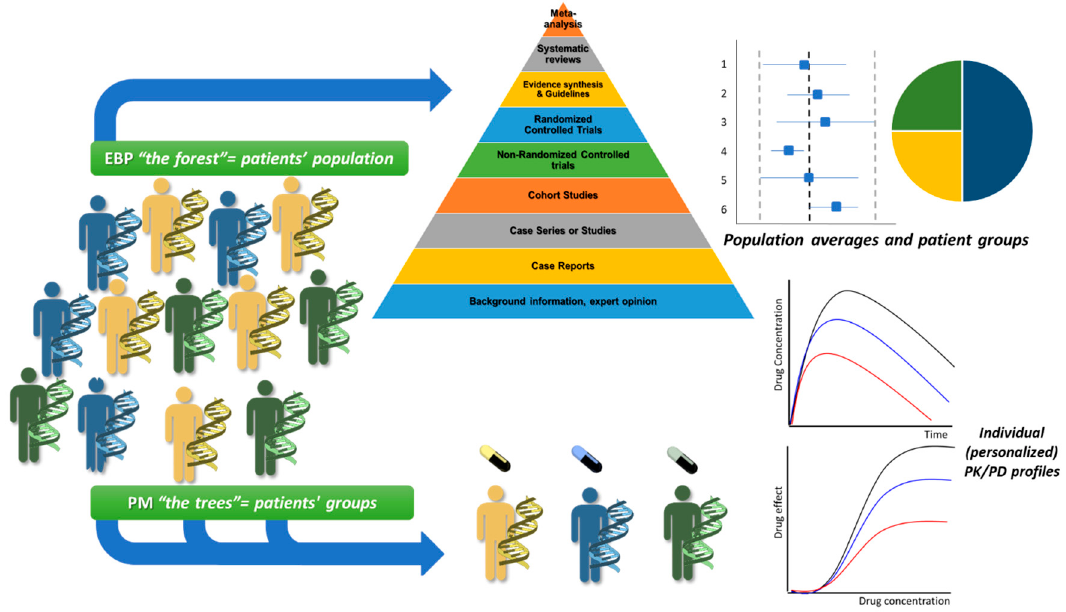
Figure 2. Evidence-based practice (EBP) and precision medicine (PM) represent complementary approaches in a modern healthcare system.